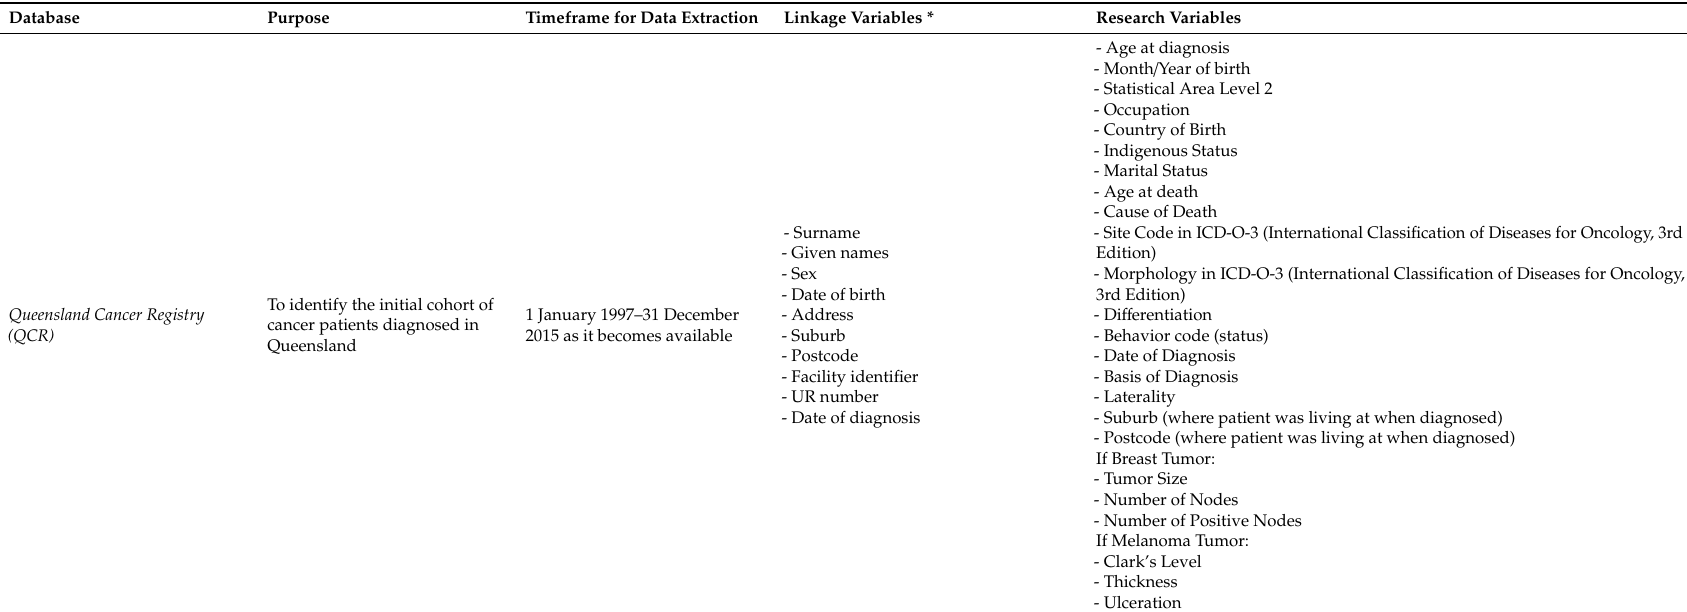
Table A1. Description of databases and variables used for data